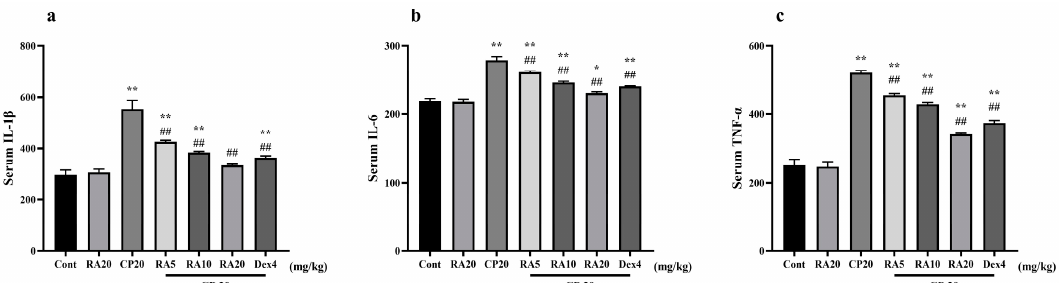
Figure 3. Effects of RA on CP-induced levels of IL-1 β , IL-6, and TNF- α in serum. The expression levels of the serum inflammatory factors IL-1 β ( a ), IL-6 ( b ) and TNF- α ( c ) in mice were detected by ELISA. These experiments were repeated three times. * denote significant differences ( p < 0.05) and ** and ## denote highly significant differences ( p < 0.01) compared with the control and CP model groups,